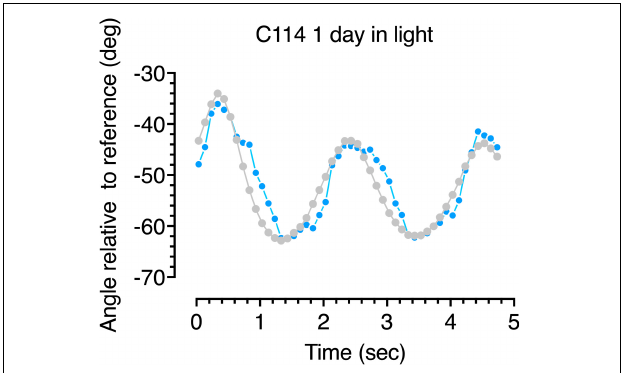
FIGURE 6 | Gaze following responses (blue symbols) to a swinging large pendulum (gray symbols) for a 6-week dark-reared kitten (C114) made on the second day of exposure to light.